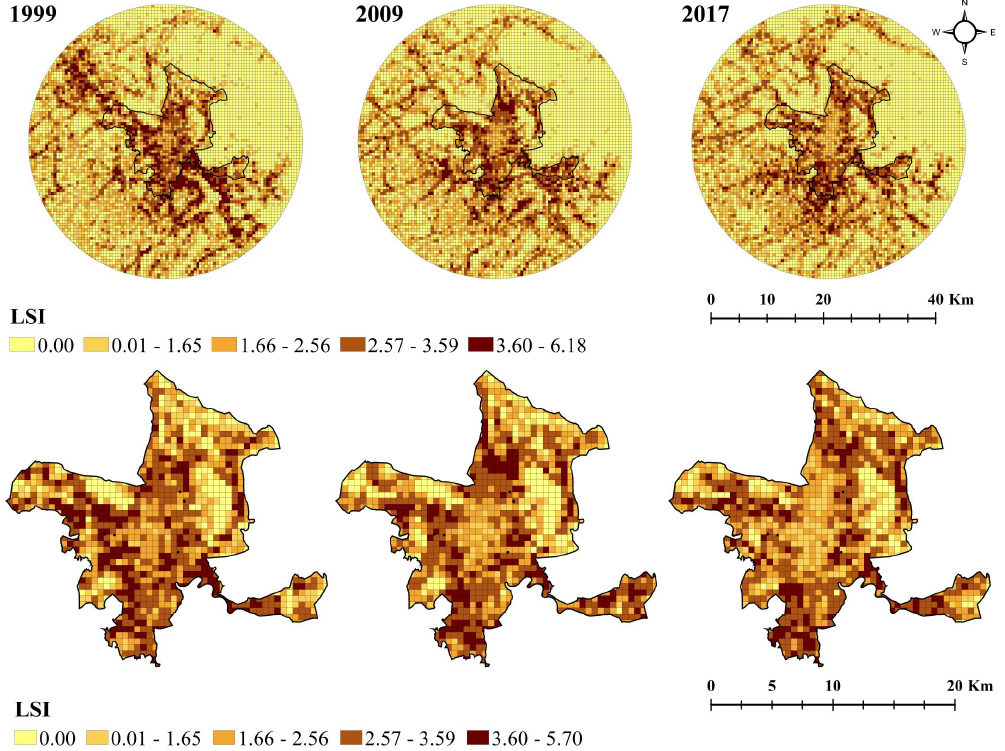
Figure 10. Landscape shape index (LSI) change at 500 m cell size with enlarged view of CA, year 1999, 2009 and 2017 in the study area.